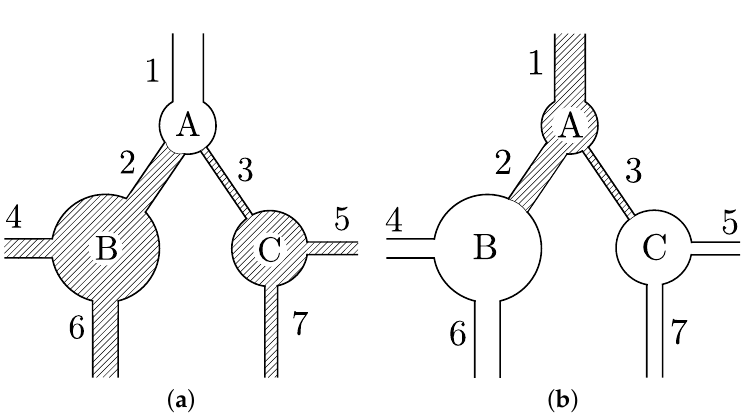
Figure 2. Retention behaviour: A simple 2D network subjected to ( a ) drying and ( b ) wetting. The hatched areas represent the wetting fluid. The drying and wetting fluid for cases ( a ) and ( b ), respectively, is allowed to enter the network from Pipe